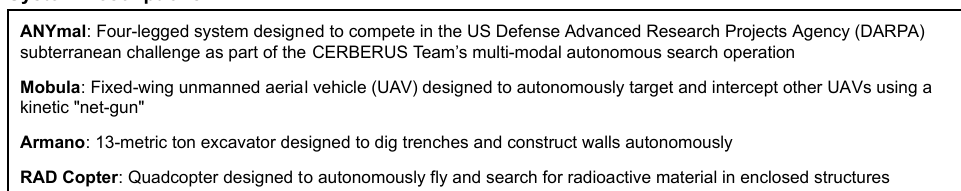
Figure A1. Overview of the Assessments of Four Autonomous Robotic Systems.